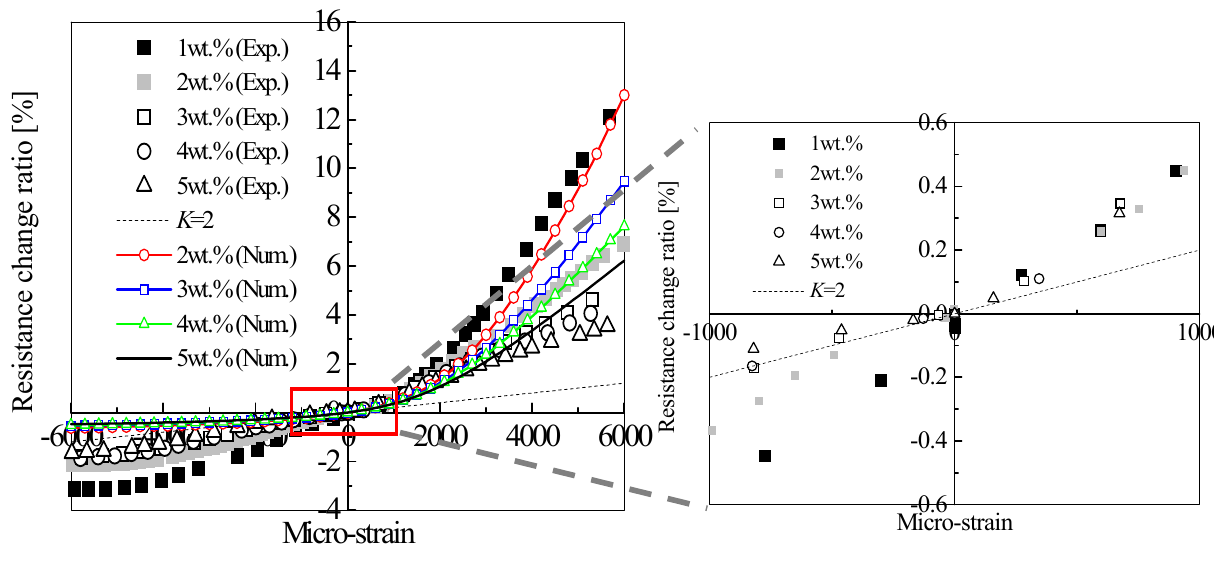
Figure 10. Comparison of sensor piezoresistivity for various MWNT